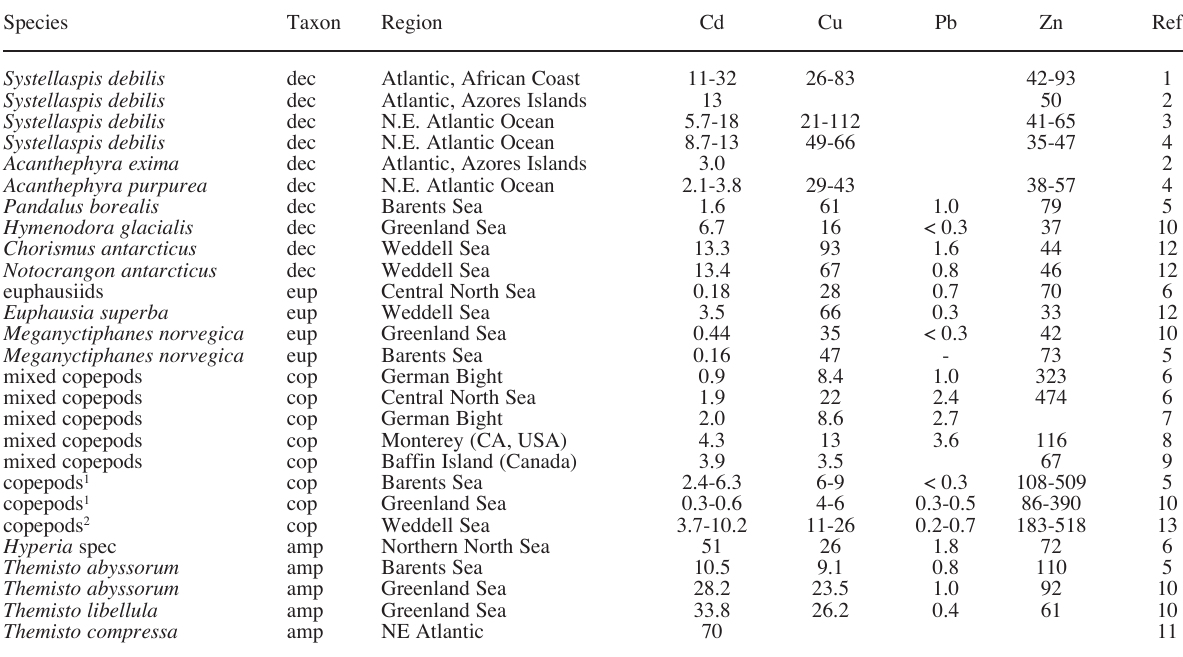
T ABLE 4. – Trace metal concentrations for different regions of the world [mg kg -1 d.w.]: taxa: dec = Decapoda; amp = Amphipoda; eup = Euphausiacea; cop = Copepoda. References: 1: Ridout et al. (1985); 2: Leatherland et al. (1973); 3: White and Rainbow (1987); 4: Ridout